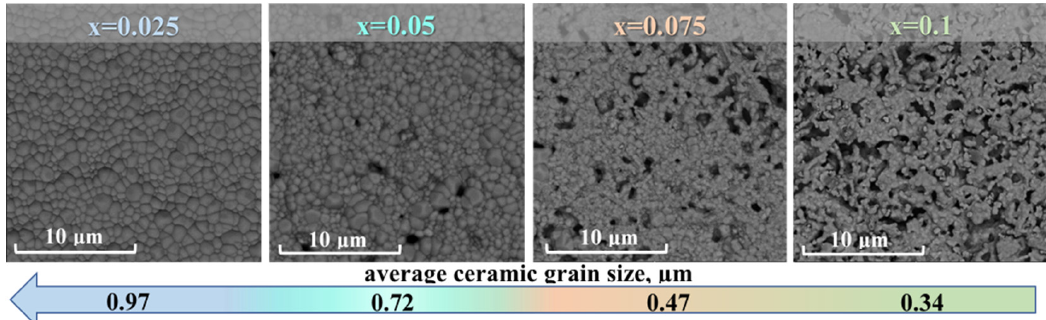
Figure 3. SEM images of surface morphology of La 1-x Ba x ScO 3- δ ceramics.